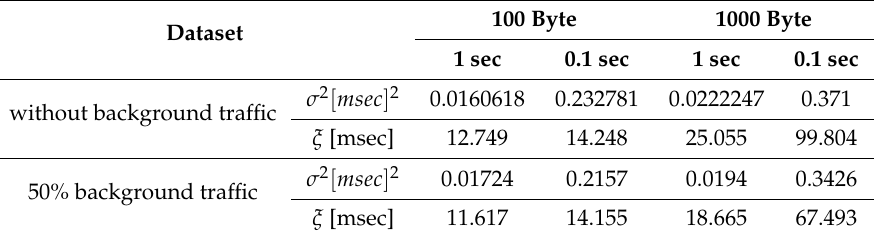
Table 7. Variance and absolute deviation around the expected packet arrival.